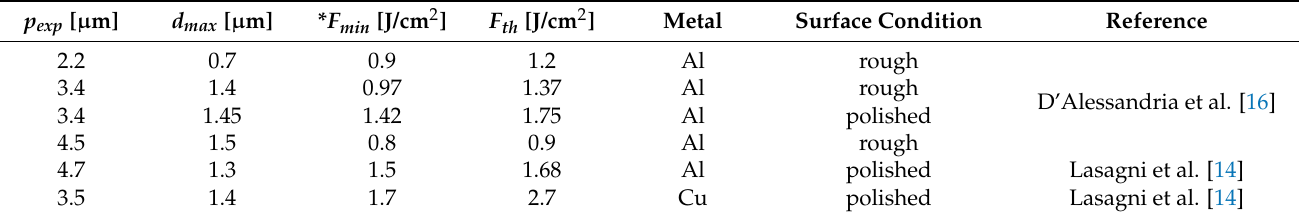
Table 1. Survey of surface topology features for single pulse laser-interference processing of pure Al and Cu reported in the literatures. p exp [ µ